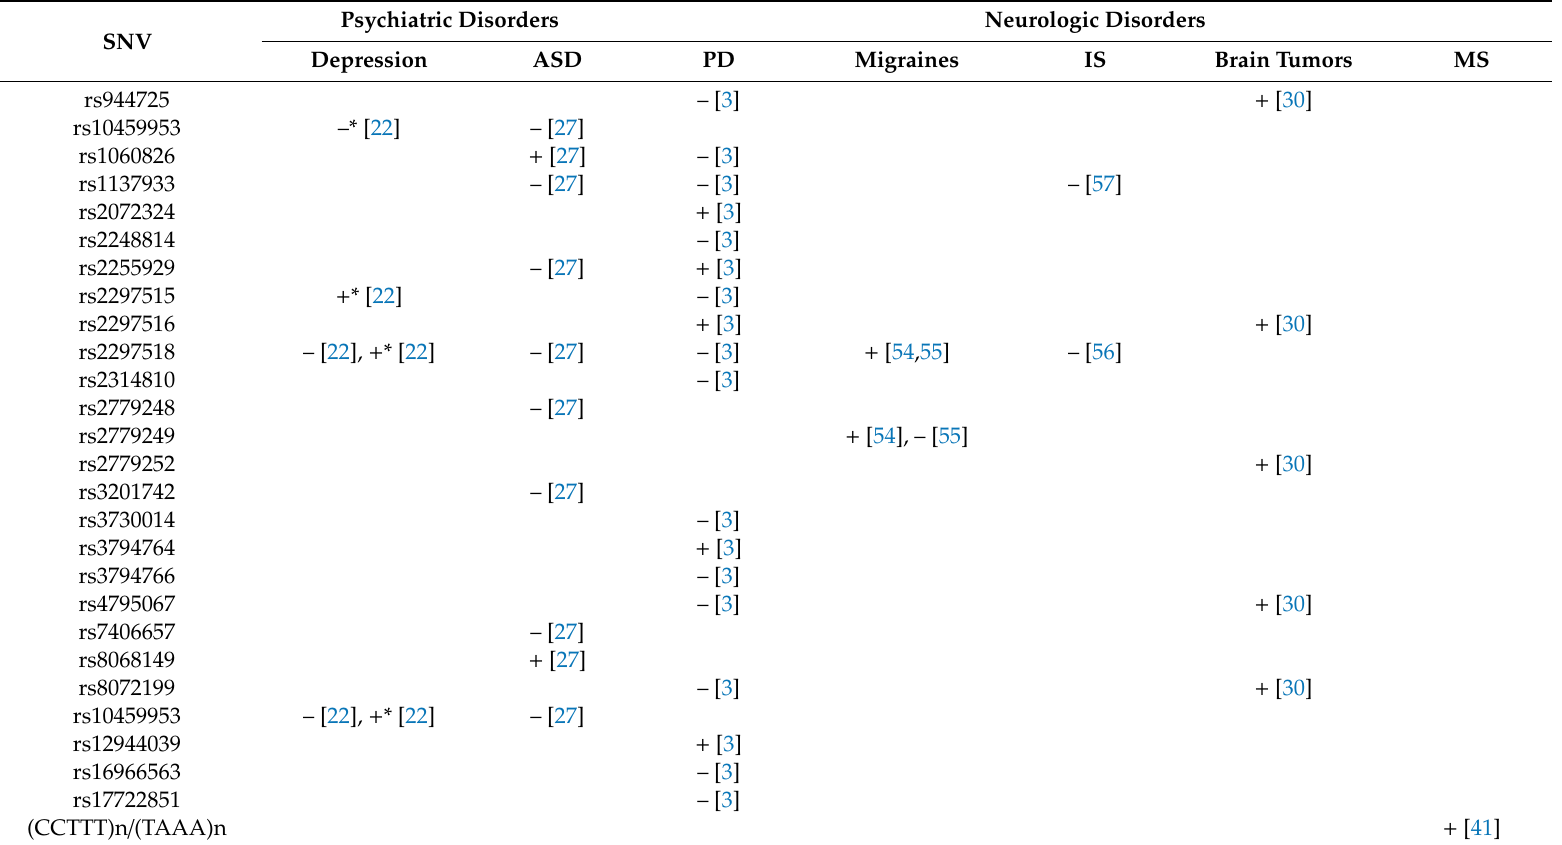
Table 2. Association of NOS2 SNVs with neuropsychiatric disorders. IS: Ischemic